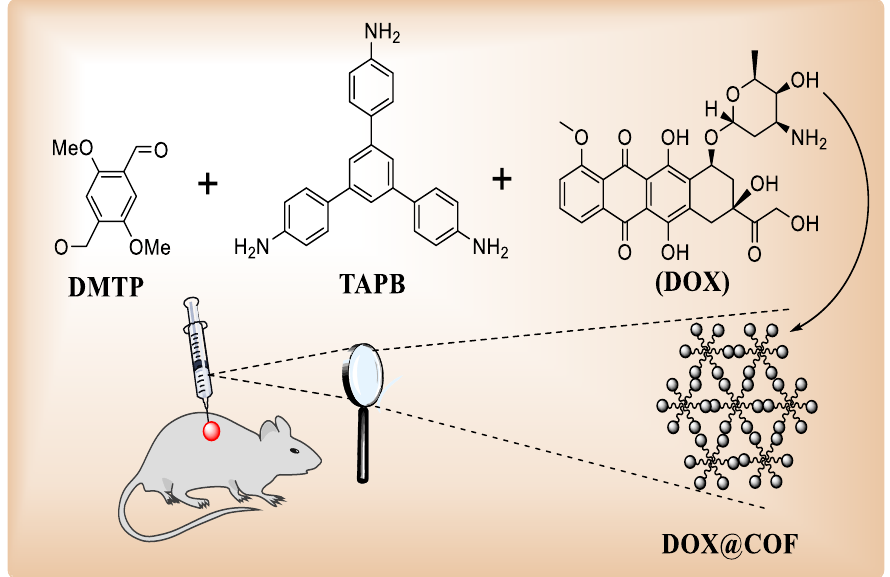
Figure 9. Combining DOX and TAPB-DMTP-COF. “Reproduced with permission of John Wiley and Sons (Chemistry — A European Journal) from One-Pot Synthesis of DOX@ Covalent Organic Framework with Enhanced Chemotherapeutic Efficacy by Liu, S.; Hu, C.; Liu, Y.; Zhao, X.; Pang, M.; Lin, J. in Chem. A Eur. J. 2019, 25, 4315 – 4319 [99] ”.